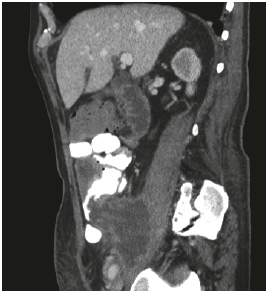
Figure 40: Computer tomographic image showing a ruptured mucocele from mucinous adenocarcinoma leading to pseudomyxoma